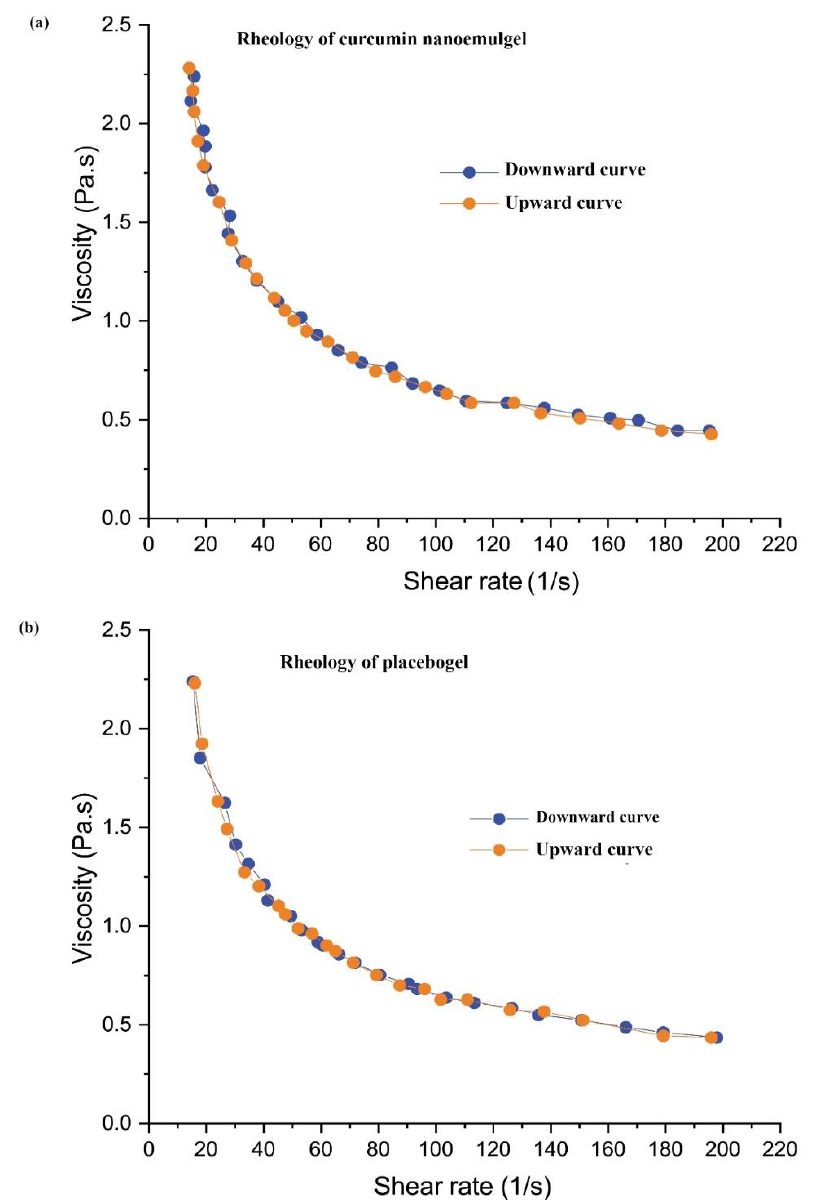
Figure 3. Rheology profile of ( a ) placebo gel and ( b ) Nanoemulgel of curcumin.